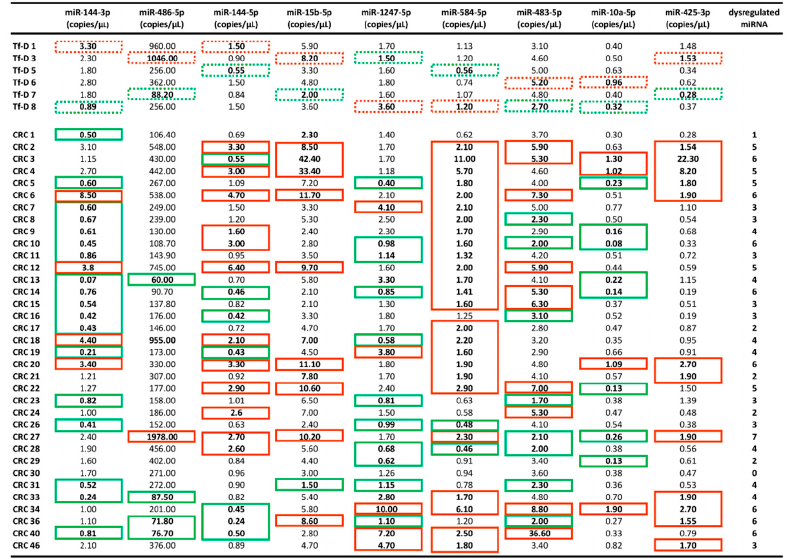
Figure 4. miRNA content in plasma samples. Plasma miRNAs levels (copies/µL) in Tumor-free Donors (from Tf-D1 to Tf-D8) and CRC (from CRC1 to CRC46) plasma samples. Values detected by dd-RT-PCR. The dotted green and red boxes in the control samples indicate the plasma lowest (green) and highest (red) miRNA levels used for comparison with the CRC samples. In the CRC samples, the solid green boxes show down-regulated miRNA values (lower values with respect to the lowest values found in controls), while the solid red boxes show up-regulated miRNA values (higher values with respect to the highest values found in controls). The number of dysregulated miRNAs is indicated from each CRC sample in the last right columns (this numbers in several CRC samples increase considering the analysis of miR-141-3p, miR-221-3p and miR-222-3p shown in Figure 1C). A further analysis comparing CRC values with the average values found in controls is reported in Figure S2. A comparison of miR-15b-5p, miR-584-5p and miR-425-3p (displaying an upregulation trend in CRC samples), and miR-141-3p, miR-221-3p and miR-222-3p, is shown in Table S3. 2.3. dd-RT-PCR Assessment of the 9-miRNA CRC Signature on the Full Experimental Dataset Figures 4 and 5A summarize the complete quantitative analysis of the 9-miRNA signature in the plasma of tumor-free donors (Tf-D) and CRC samples ( n = 6 and n = 35, respectively). When compared to the training set, the full dataset revealed a wider scatter in the observed values, as expected. Nevertheless, overall trends (increases in miR-584-5p, miR-15b-5p, and miR-425-3p and decreases in miR-144-3p, miR-144-5p, and miR-486-5p in CRC compared to normal) could be confirmed in at least 6/9 miRNAs. The two most significant changes in miRNA levels were seen for miR-584-5p (up- regulated) and miR-144-3p (down-regulated), Mann–Whitney p = 0.016 and p = 0.046, respectively. Data are analytically displayed in Figure 4 as copies/uL of miRNA in plasma, and the dysregulation (up- or down-regulation relative to control) is individually noted for each patient. Although single miRNAs in the 9-miRNA CRC signature may not be informative in individual patients (the most informative was miR-584-5p, that was found upregulated in 25/35 patients), it is readily evident from Figure 4 that, in all but one (CRC30) of the 35 tested CRC samples, there are from 2 to 8 dysregulated miRNAs. Therefore, the 9-miRNA signature is informative as to the CRC disease status at surgery in 97.1% of the CRC patients tested in this study. The data depicted in Figure 4 were supported by a further analysis conducted comparing the values in CRC samples with the average values found in controls and reported in Figure S2. Of interest, some individual CRC plasma samples behaved as